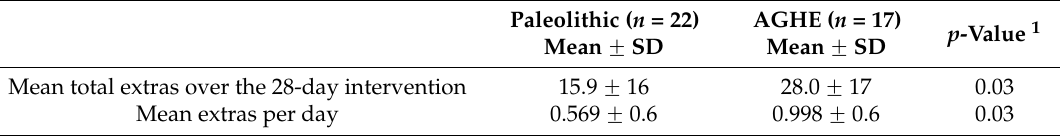
Table 1. Compliance assessment using number of serves of extras food per